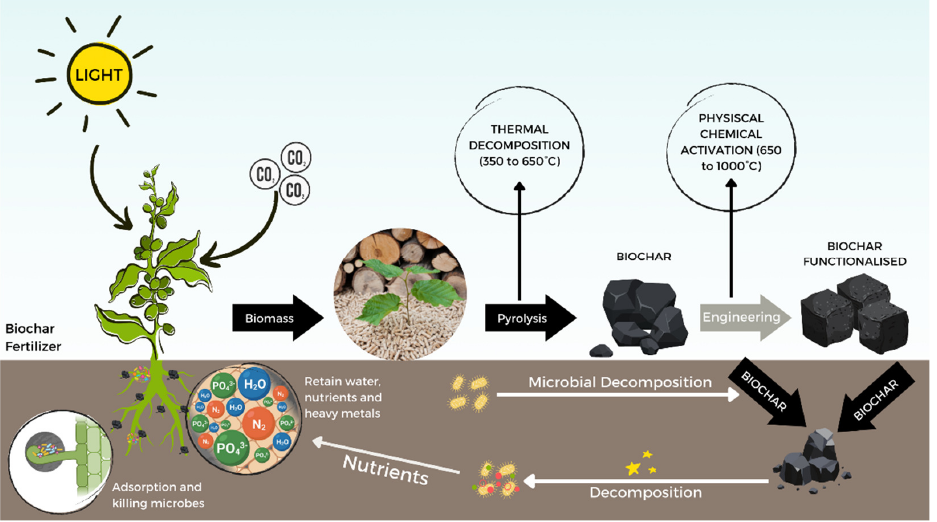
Figure 4. Cycle of biochar production, modification and applications in the soil and mechanism of protection from diseases.